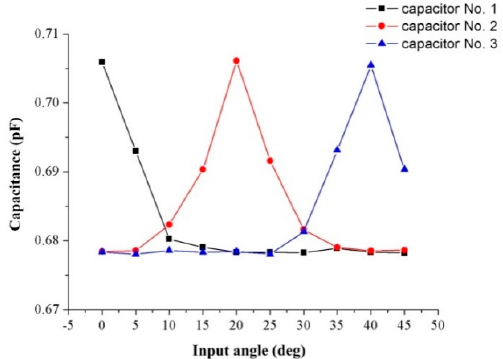
Figure 15. The mutual capacitance of three capacitors.